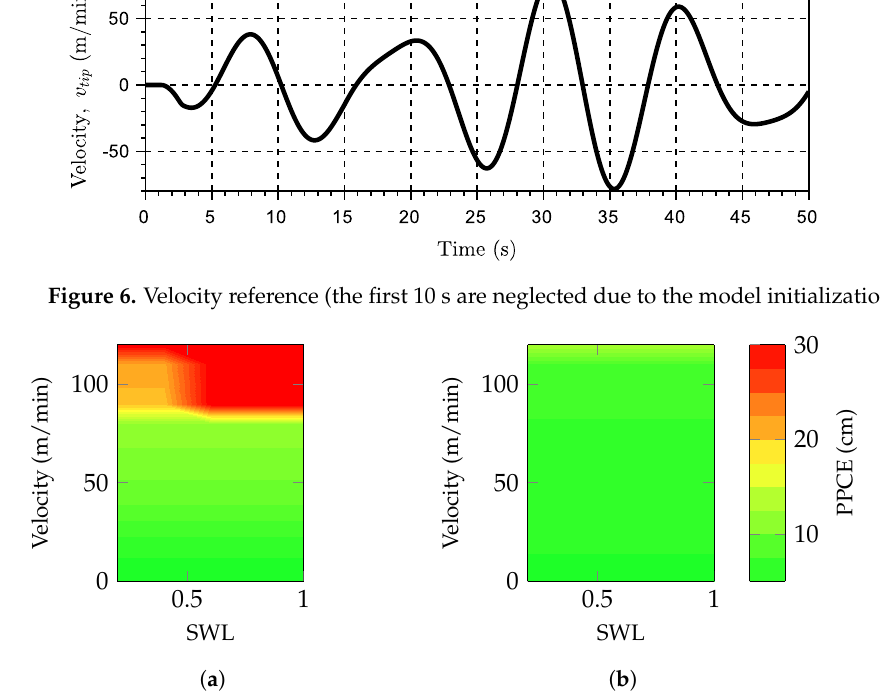
Figure 7. Maximum peak-to-peak control error (PPCE) during the test sequence: ( a ) Classic; ( b ) SSC.